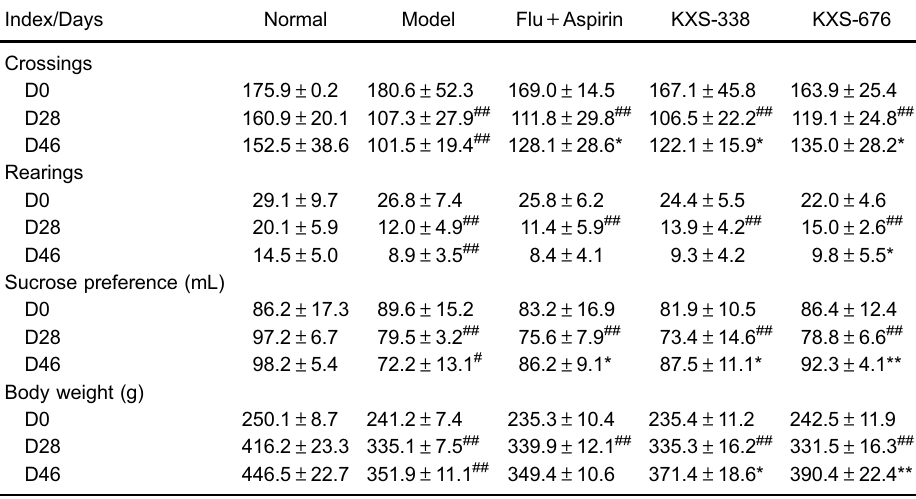
Table 1. Effects of Kai-Xin-San (KXS) on behaviors measured on days 0, 28 and 46, in fl uoxetine-resistant depression (FRD) rats exposed to chronic and unpredictable mild stress